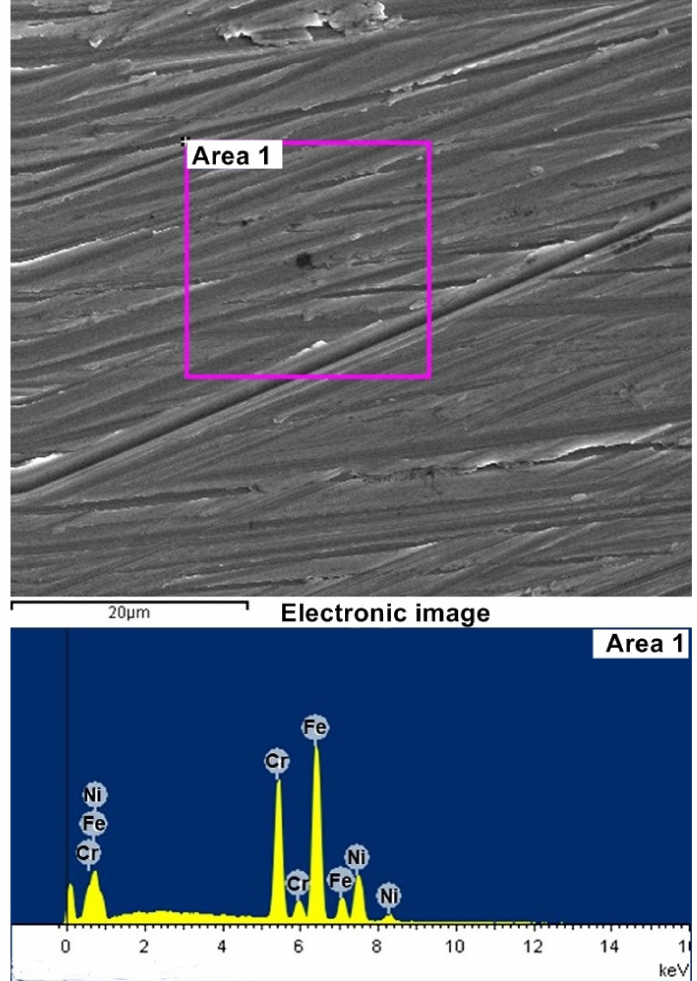
Figure 5. Composition of surface film of SiN stainless steel in nitric acid liquid